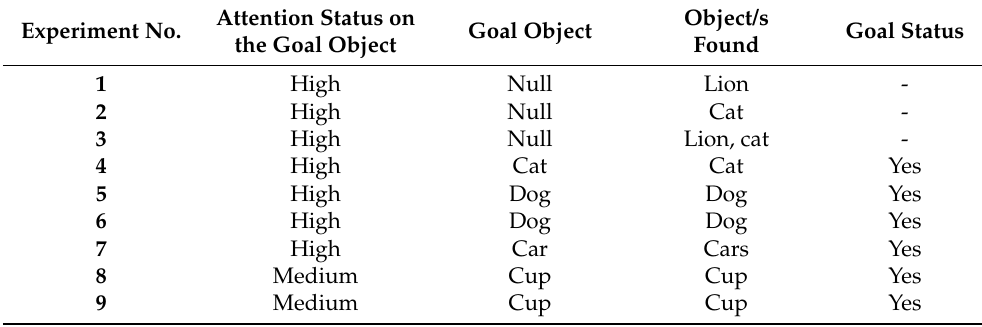
Table 6 defines the attention status and goal achievement without emotions. Table 6. This table defines the summary of experiments (attention). This table first defines attention type. Then in the goal object feature, it shows the queried object, and at last, it represents the status of attention towards an object.